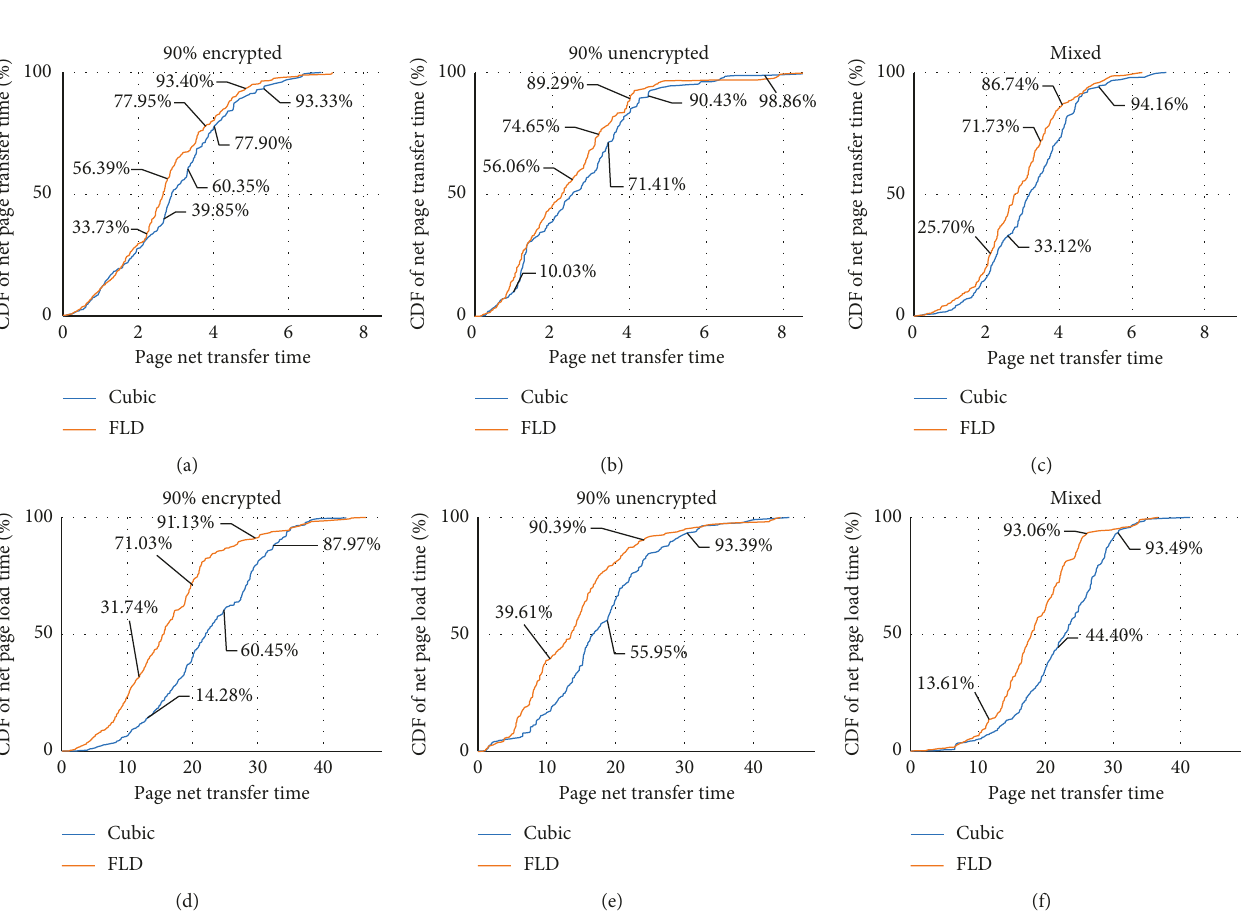
Figure 6: Page net transfer time (LTE upper figure and 3G lower figure) (seconds) obtained for different page types for Cubic and